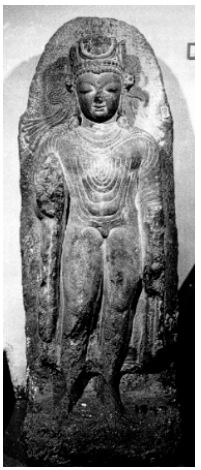
Figure 7. Buddha wearing a crown. Eighth c. Parihasapura, Kashmir. Stone. H 128.2 cm. Sri Pratap Singh Museum, Srinagar, Kashmir. Photograph courtesy of John C. Huntington.